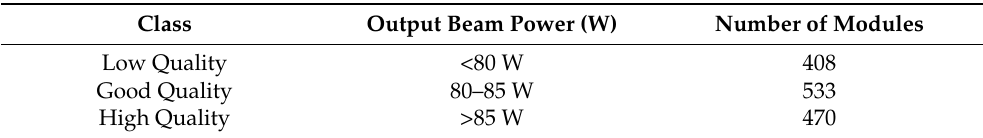
Table 2. New classification of the modules based on their output